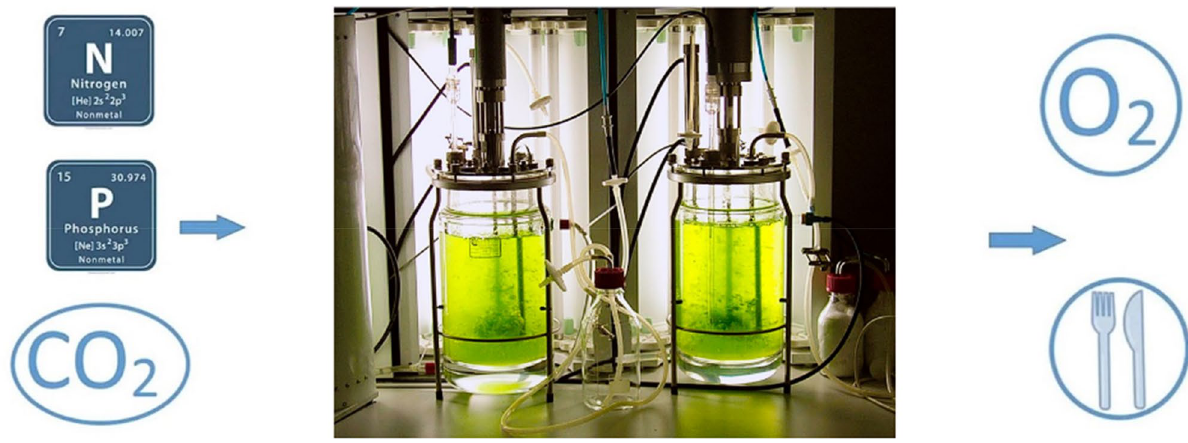
Fig. 15 A schematic detail of the photobioreactor and superior plants with its chemical reaction is carried out in compartment 4